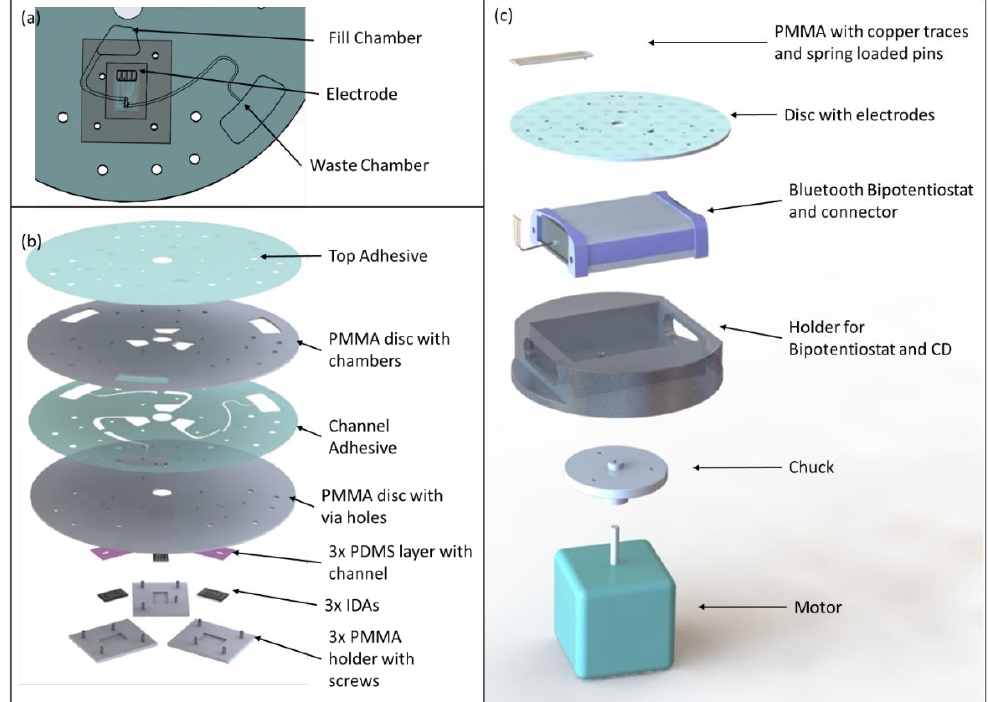
Figure 1. ( a ) Fluidics on Compact Disc (CD) and positioning of electrode underneath disc, ( b ) Assembly of modular CD. Electrodes can be removed for cleaning and replacement, ( c ) Test setup for non-contact measurements.